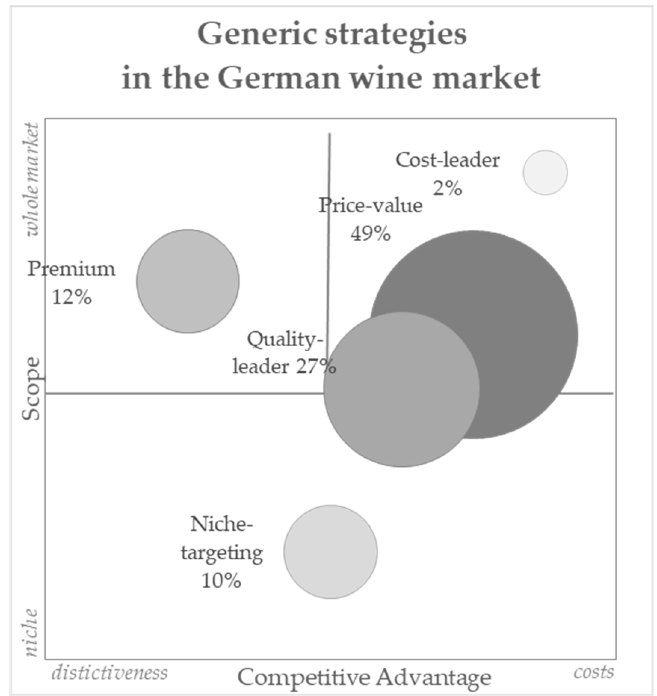
Figure 6. Strategic landscape of the German wine industry (survey results).